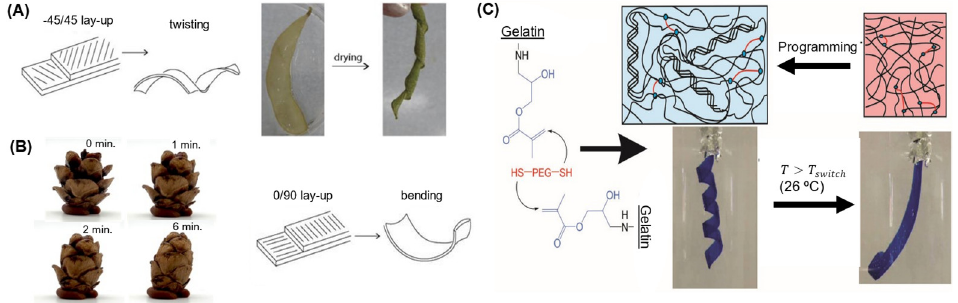
Figure 5. Twisting gelatin actuators and plant-inspired actuation. ( A ) Solvent actuated twisting ac- tuation in edamame seedpods with clay composite twisting actuation scheme [86]. ( B ) Conifer pine- cone bending motion when dried out to when fully hydrated (original images) with clay composite bending actuation scheme [86]. ( C ) Thermally stimulated shape memory gelatin hydrogels twisting actuators (Adapted) [87]. (Images ( A – C ) are licensed under CC BY 4.0 (http://creativecom- mons.org/licenses/by/4.0/ (accessed on 30 October 2022))).